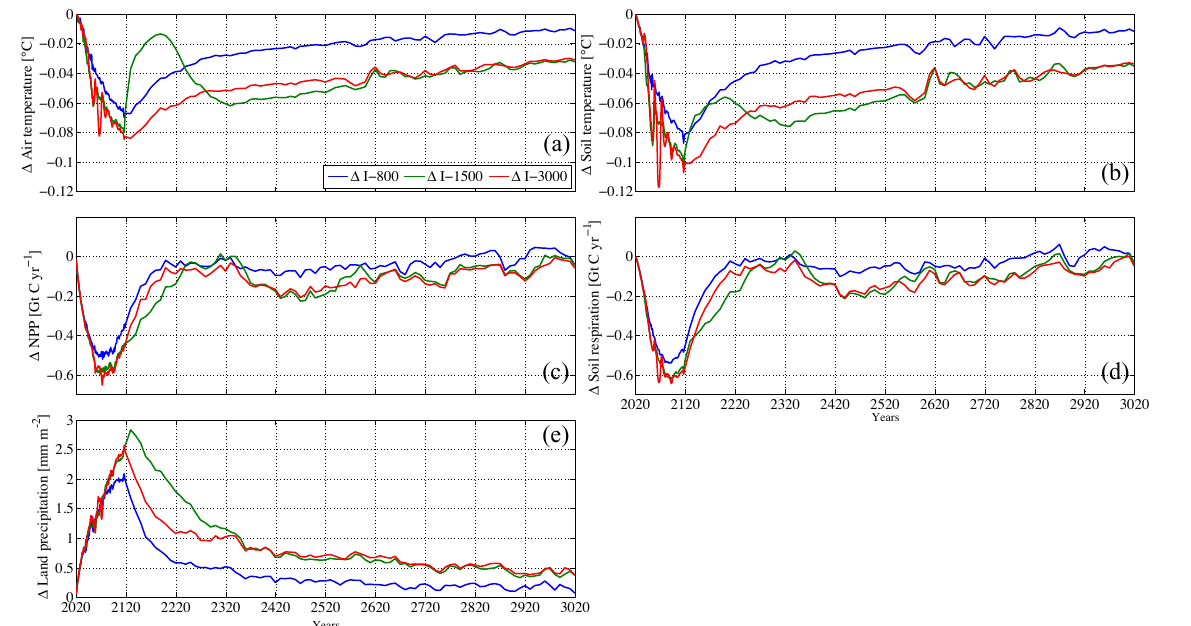
Figure 5. Absolute changes between the WE simulations and the RCP 8.5 control run for (a) global mean surface air temperature, (b) global mean soil temperature, (c) globally integrated net primary productivity on land, (d) globally integrated soil respiration and (e) global mean precipitation over